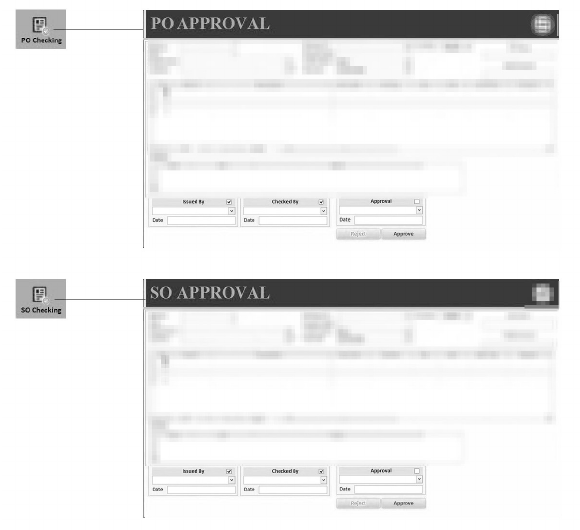
Figure 4: Sales Order and Purchase Order Approval Interface.